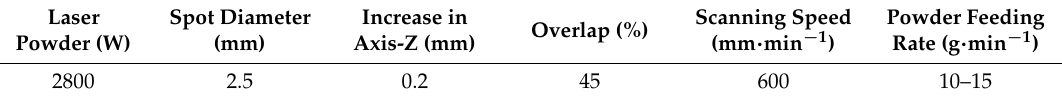
Table 1. Chemical compositions of 34CrNiMo6 powder (wt %).